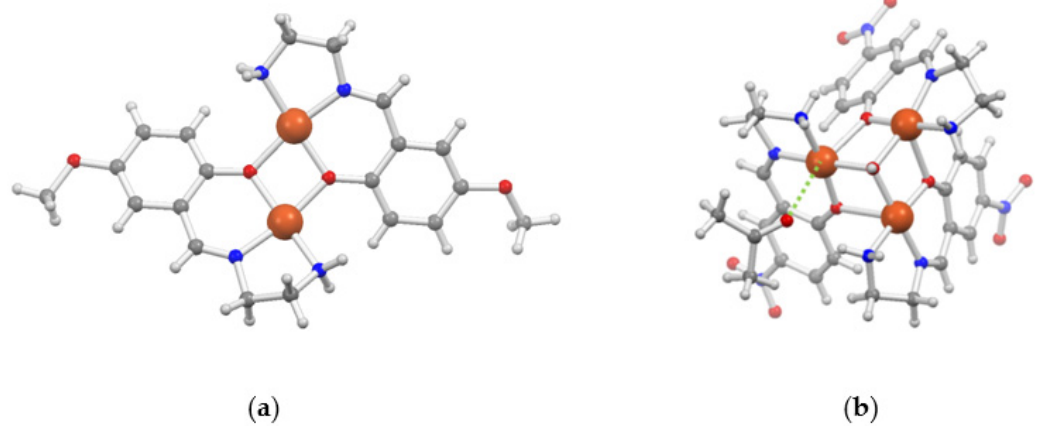
Figure 3. Molecular structures of ( a ) the dinuclear [Cu 2 ( µ - OMe L) 2 ](ClO 4 ) 2 ( OMe L – from 5-OMe-salH and en), CSD/CCDC VOGVET/684257 [39], and ( b ) the trinuclear [Cu 3 ( µ 3 -OH)( NO2 L) 3 ](ClO 4 ) 2 · acetone ( NO2 L – from 5-NO 2 -salH and en, Cu ··· O(acetone) interaction as dashed green line) CSD/CCDC VOGVUJ/684260 [39]. Reproduction of the structures with Mercury ® 4.3.1 software [71], color code: Cu = orange, O = red, N = blue, C = gray, H = white, perchlorate anions omitted for